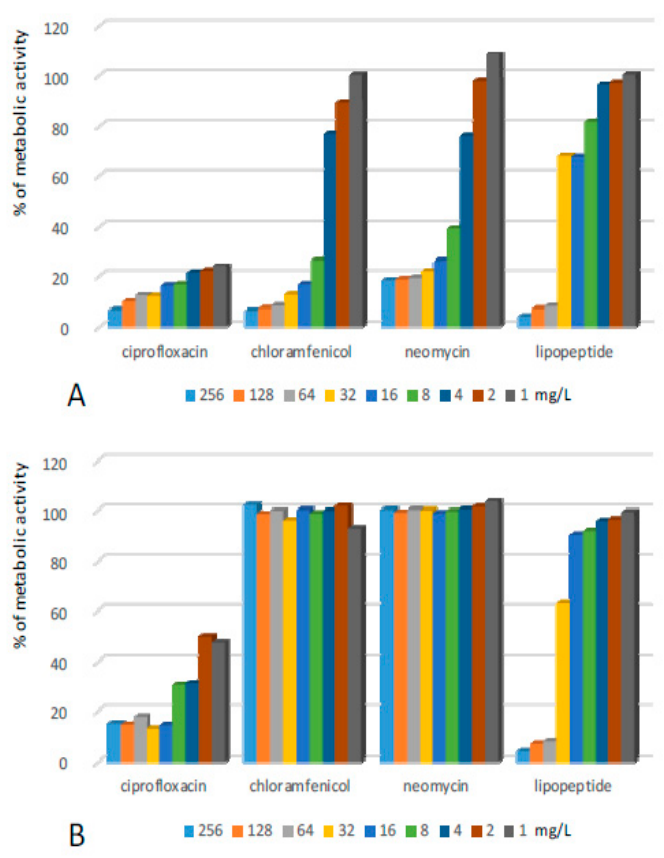
Figure 4. Activity of the lipopeptide and conventional antimicrobials applied at concentrations of 1–256 mg/L against EC biofilms formed on polystyrene ( A ) results read after 24 h exposure to compounds; and ( B ) results read after the withdrawal of compounds and additional 24 h of incubation in MHB II. The results are presented as the percentage of metabolic activity in comparison to positive (100%) and negative (0%) controls; RSD ≤ 15%.